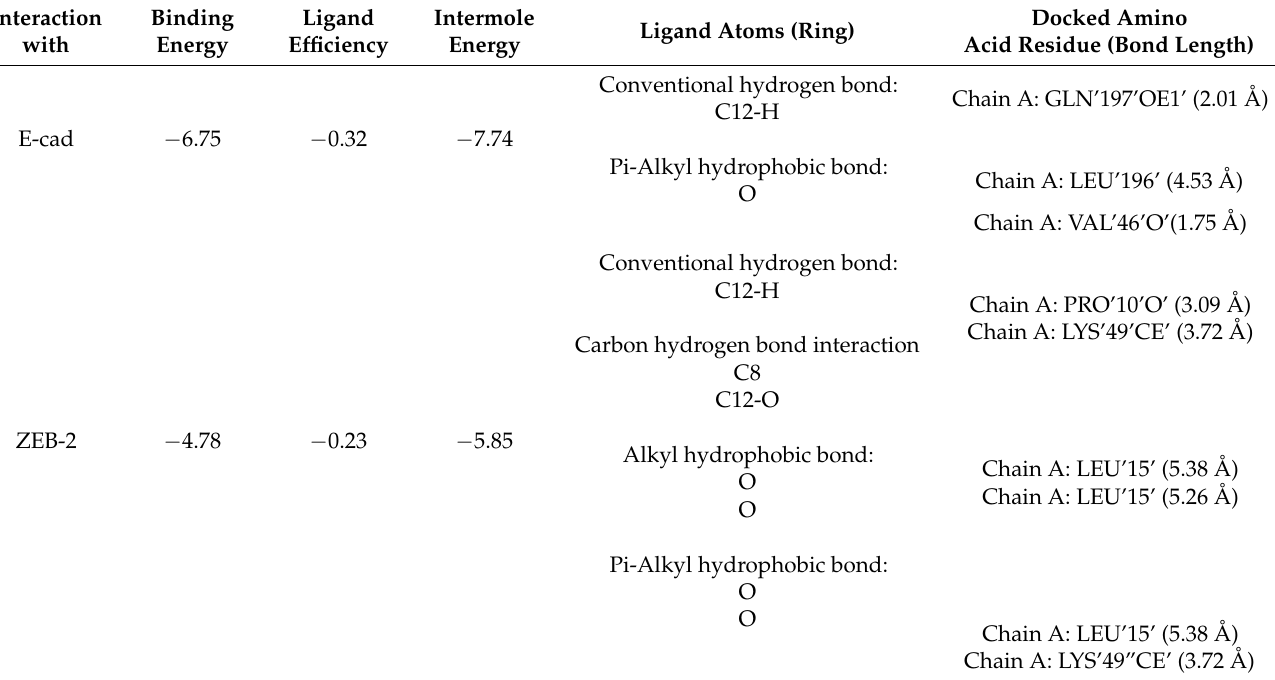
Table 1. Interactions of atropine with E-cad and ZEB-2 residues of target